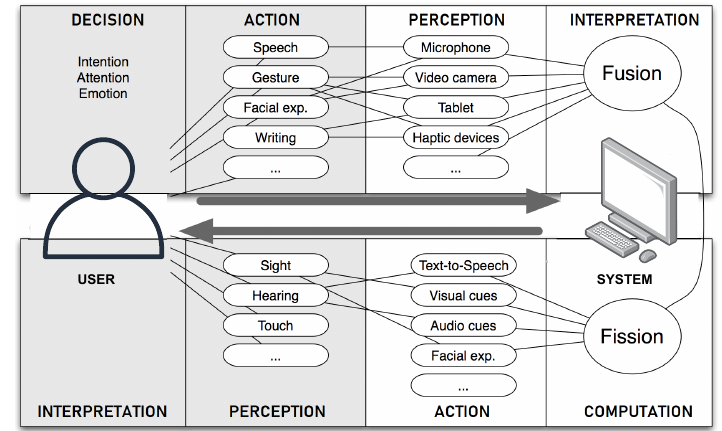
Figure 1. Multimodal human–computer interaction (adapted from